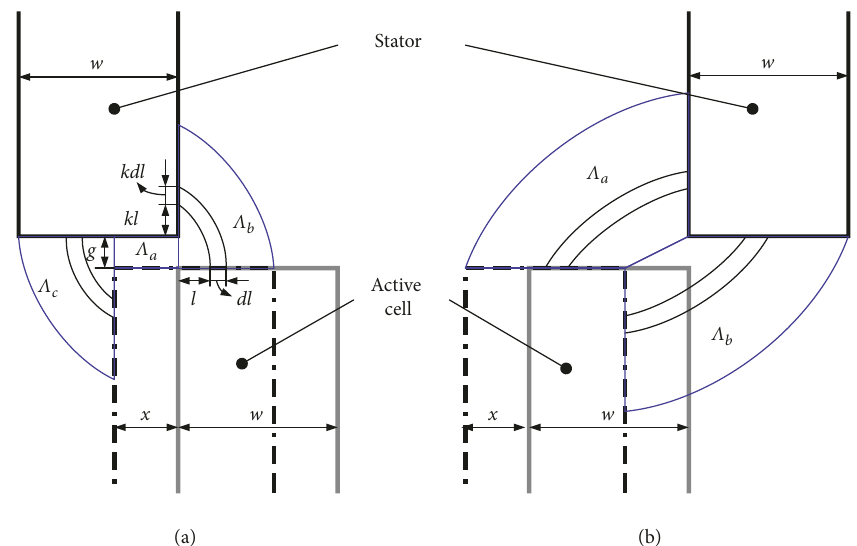
Figure 3: Air gap partition of a mechanical unit with negative stiffness.